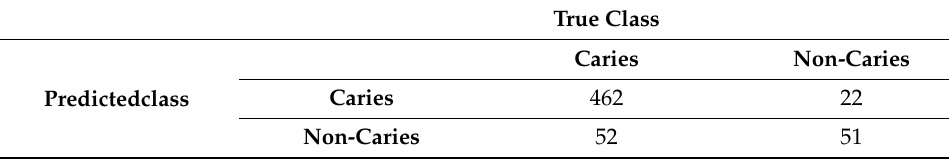
Table 3. Confusion matrix for caries detection stage.